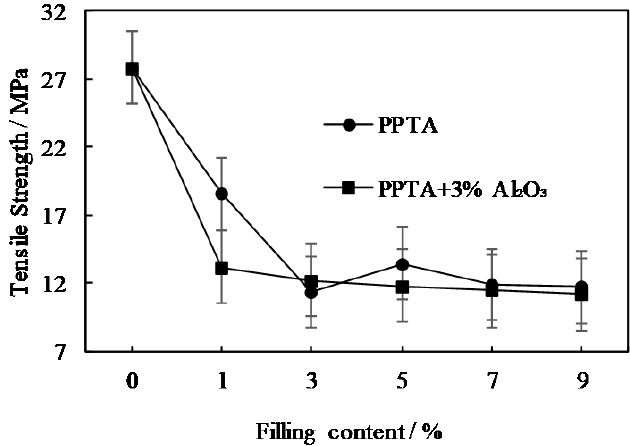
Figure 17. Tensile strength of PPTA and nano Al 2 O 3 filled modified PTFE composite.